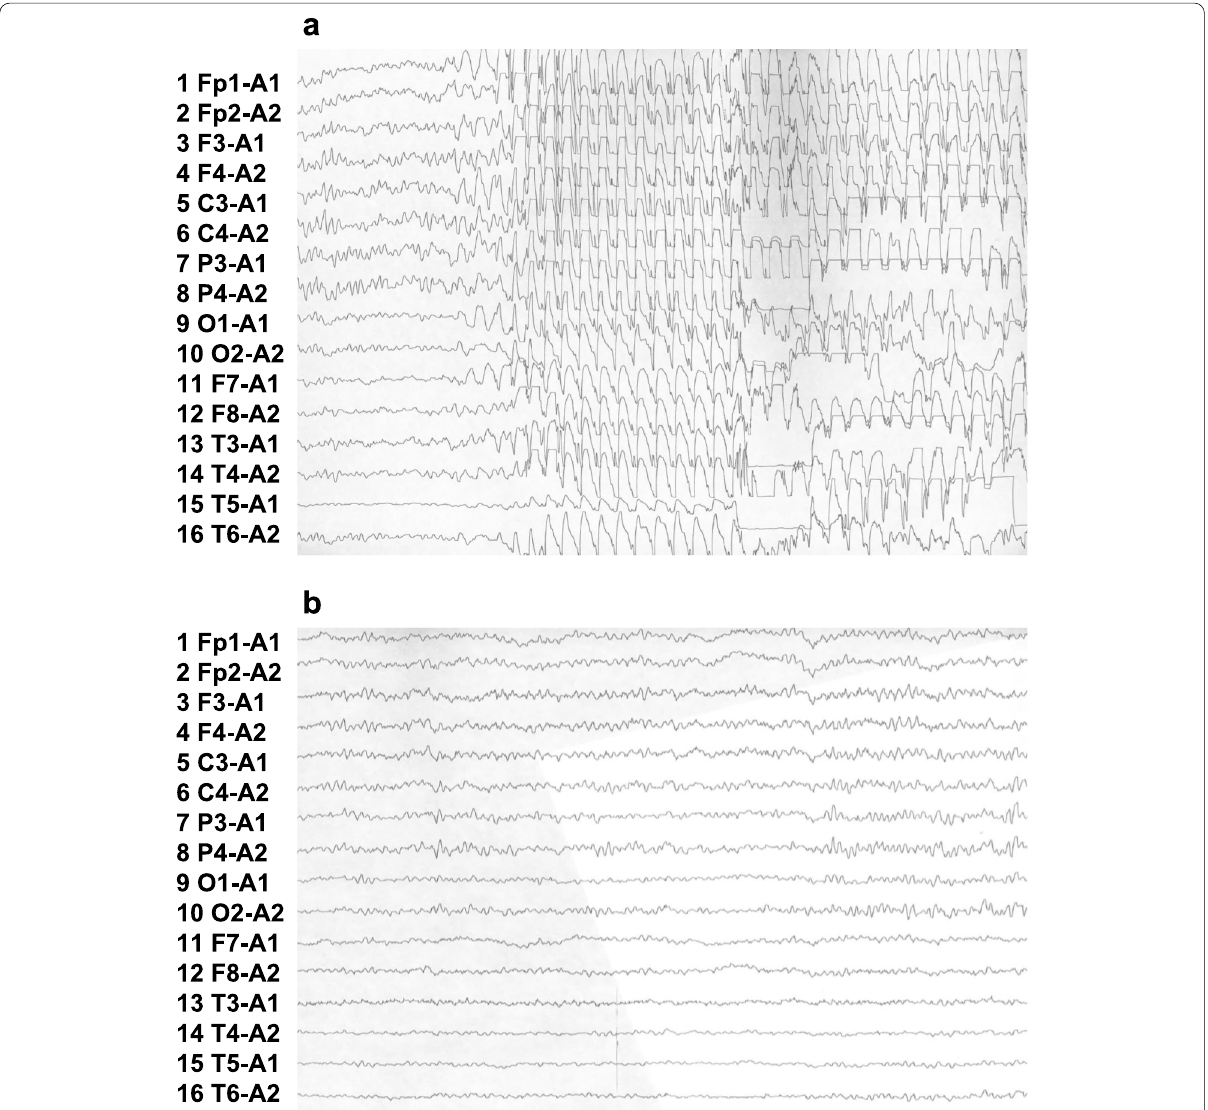
Fig. 1 The electroencephalograms of case 1. The electroencephalogram at diagnosis ( a ) showed a generalized spike-and-wave discharge at 3 Hz, and the electroencephalogram at 4 months after drug eruption ( b ) showed no abnormal